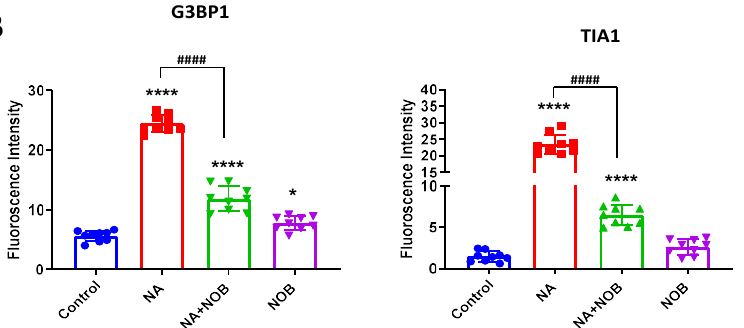
Figure 7. Effect of NOB and NA on stress granule markers G3BP1 and TIA1 in hNPCs. ( A ) Representative immunocytochemistry (ICC) images of hNPCs depicting the expression of G3BP1 and TIA1 positive granules in ( d ) Control or unexposed cells, ( h ) NA-exposed cells, ( l ) NA and NOB co-exposed group, and ( p ) NOB exposed cells; Images were taken using an Invitrogen EVOS FL fluorescence microscope. Scale bar, 100 μM. ( B ). Quantification of cells with G3BP1 and TIA1 positive granules under the indicated conditions. Fluorescent intensity was calculated by ImageJ software, and images are represented in graph format. Data are presented as mean ±SEM of three separate experiments performed in 3 biological replicates. The change in expression pattern is statistically significant as indicated by * p < 0.05, **** p < 0.0001 compared to the control and #### p < 0.0001 compared with NA-exposed cells.